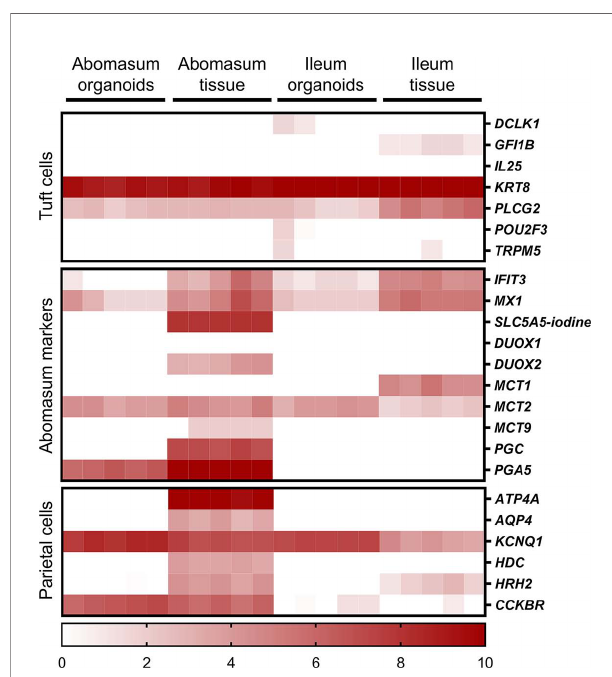
FIGURE 8 | Heat map showing the expression of genes associated with gastric epithelia in abomasum and ileum tissue and organoids. RNA-seq analysis was performed to compare gene expression in abomasal and ileal tissue derived from fi ve lambs and abomasum and ileum organoids across multiple passages. Squares from left to right under “ abomasum tissue ” and “ ileum tissue ” represent lambs T1-T5. Squares from left to right under abomasum organoids and ileum organoids represent passages P0-P4. Scale = log 2 transcripts per million reads. Details of genes included in the heat map, including ENSOART sequence identi fi ers, are shown in Supplemental File 2